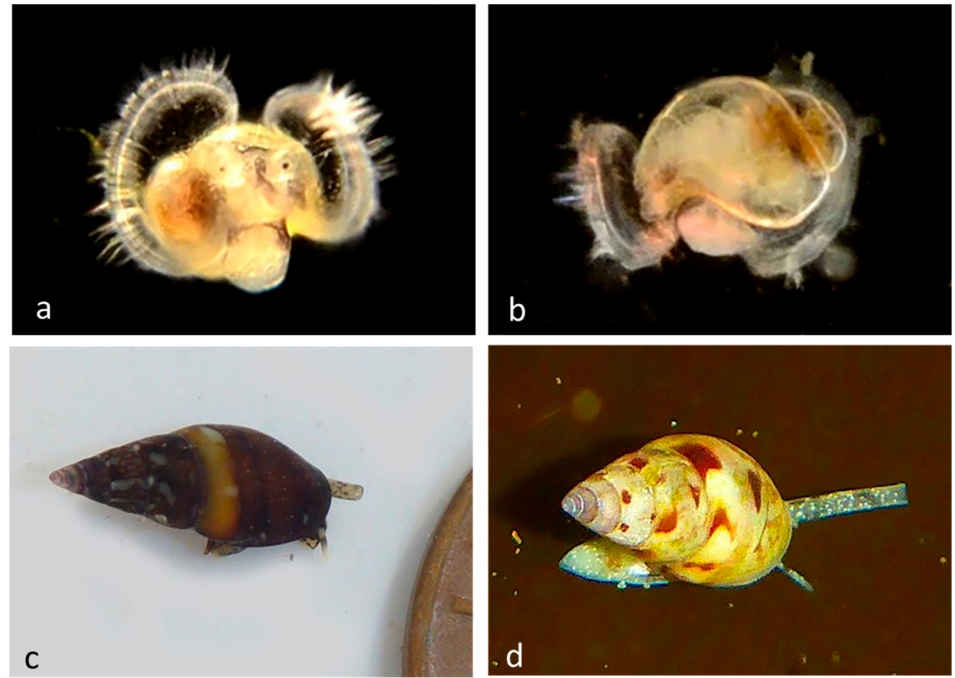
Figure 13. Family Columbellidae. Carinate dove shell , Alia carinata (BIN AAZ4577). ( a ) Veliger BIOUG01229-G06 from Newport Beach, Harbor entrance. ( b ) Late veliger BIOUG01229-C06 from Pacific Ocean from Crystal Cove State Park. ( c ) Adult CCDB-24002-H02 from Dana Point rock field. ( d ) Adult CCDB 31729 D02 from Twin Points, Crystal Cove State